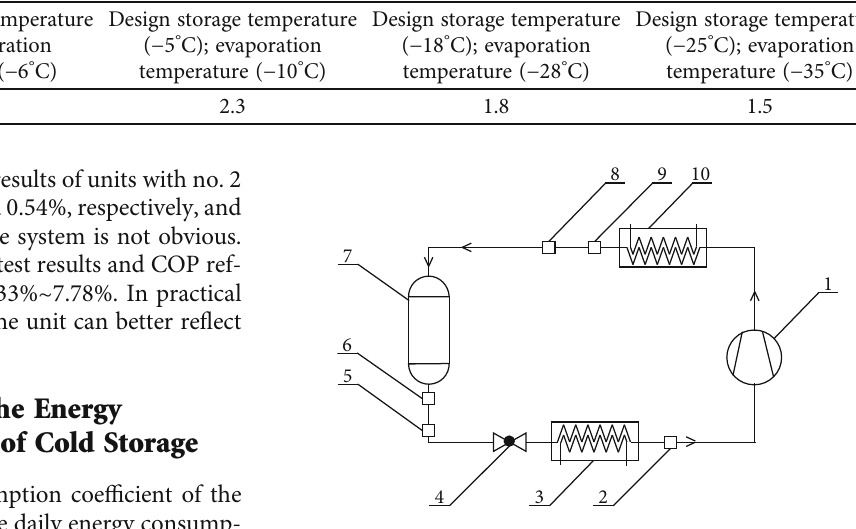
Figure 8: Sketch map of measuring point position where